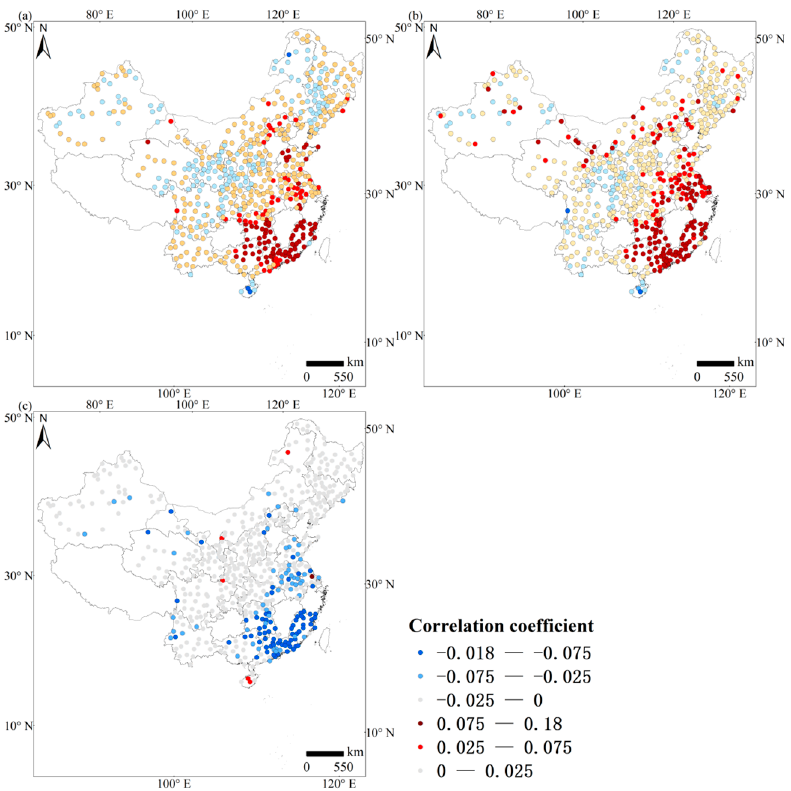
Figure 1. Correlation between different ENSO indexes and meteorological drought: ( a ) correlation between Niño3.4 and SPEI; ( b ) correlation between MEI and SPEI; ( c ) correlation between SOI and